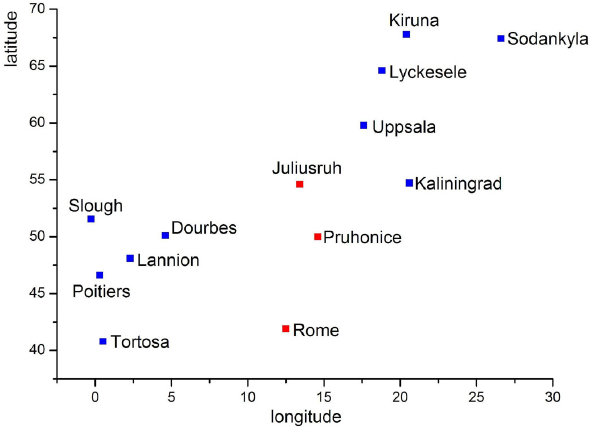
Fig. 1. Geographic area showing the 13 ionospheric observatories for which the local forecasting models were developed. The blue dots mark the western and eastern parts of the area under consider- ation; the red dots mark the central part of